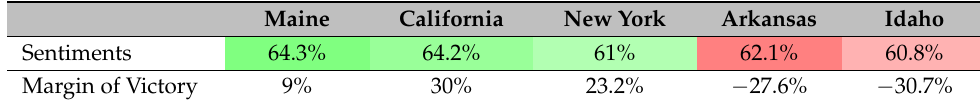
Table 4. Biden: extreme positive and negative sentiment states with margin of victory.